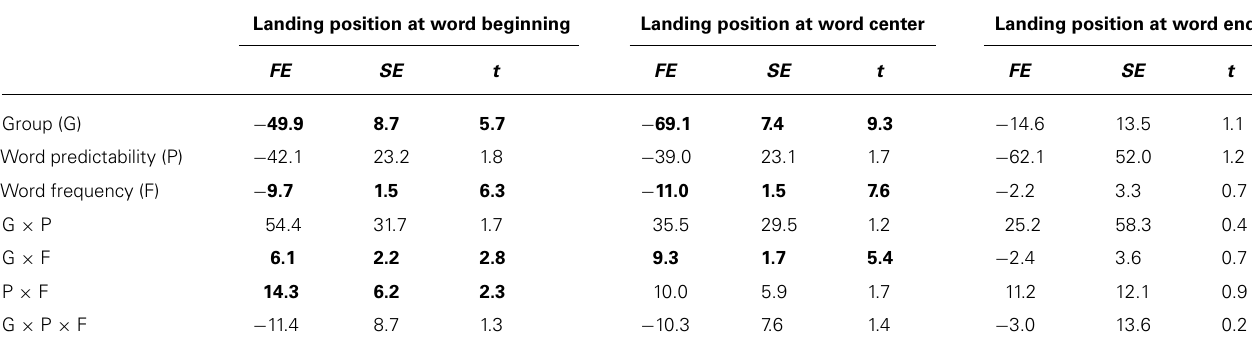
Table 3 | Results from LMM analysis for first fixation durations of multiple fixation cases with reading group, word frequency and predictability as fixed effects and participants and items as random